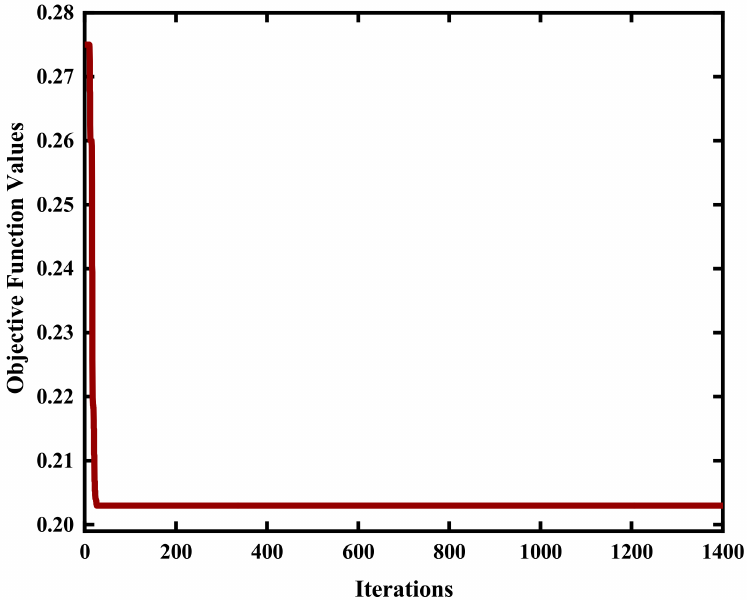
Figure 7. Convergence characteristics of SPSO. Table 3. Load flow results for DN with DGs through